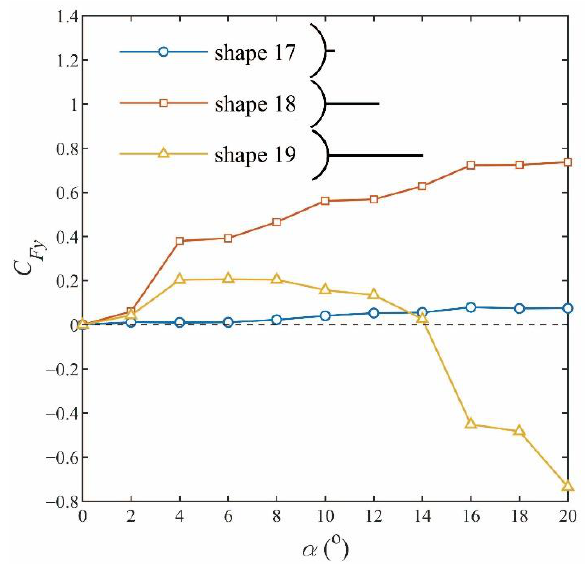
Figure 12. Variation of transverse force coefficient C Fy with wind attack angle α for bluff bodies with different tail lengths.